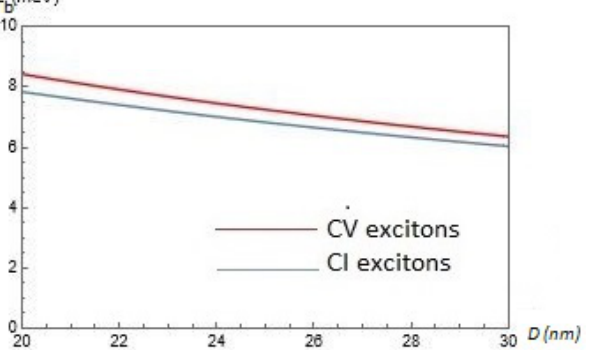
Figure 4. The exciton binding energy E b ( α , ∆ , D ) for CV and CI excitons as functions of the interlayer separation D for chosen parameter α = 0.6 and gap ∆ = 0.5 ¯ hv F / a .